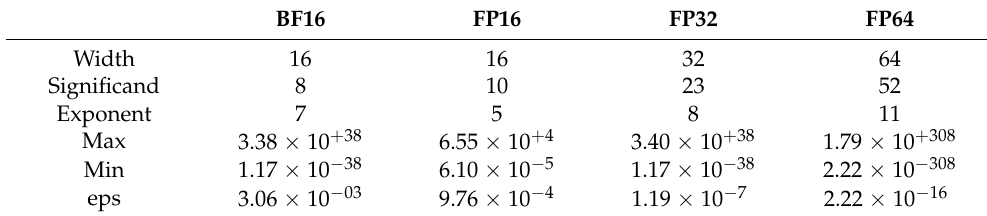
Table A1. Floating-point number size, bits.